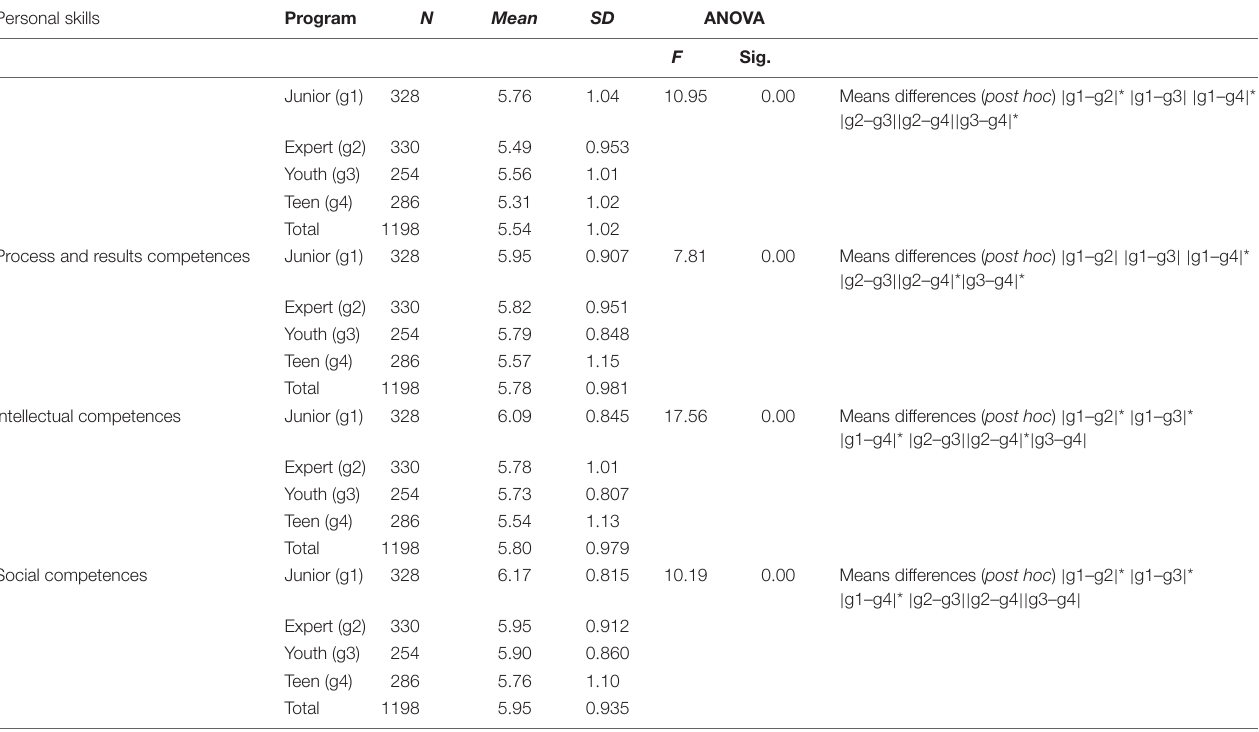
TABLE 7 | Students’ overall skills and competences among four programs (Anova and post hoc ). Personal